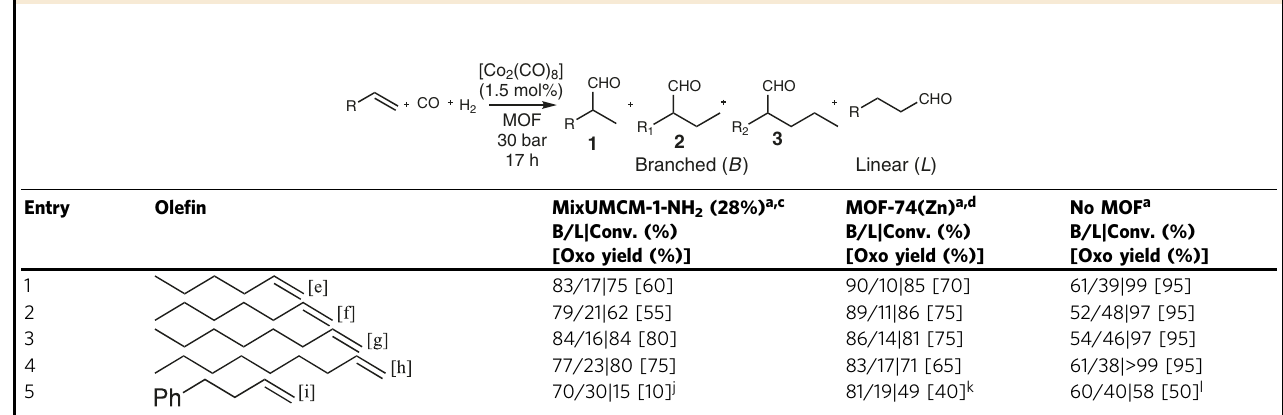
Table 3 Substrate scope of the Co-catalysed hydroformylation of ole fi ns without directing groups with MOF additives and comparison with the homogeneously catalysed reaction a,b .